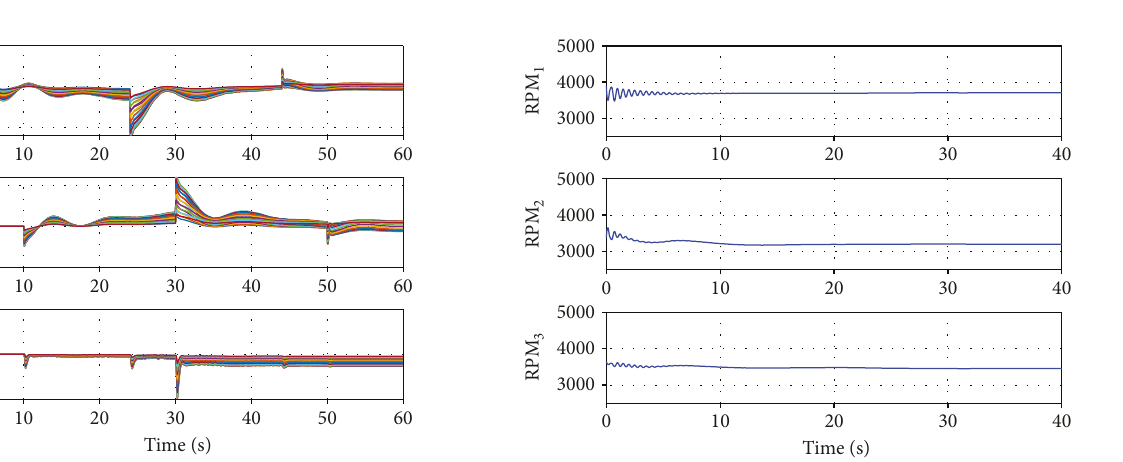
Figure 14: RPM control input when considering the neural network in scenario 2.